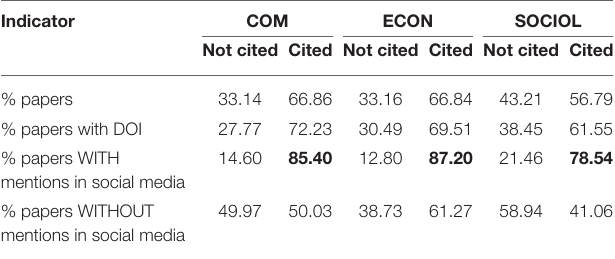
TABLE 6 | Percentage of papers cited with and without DOI and with and without mentions in the social media by discipline.